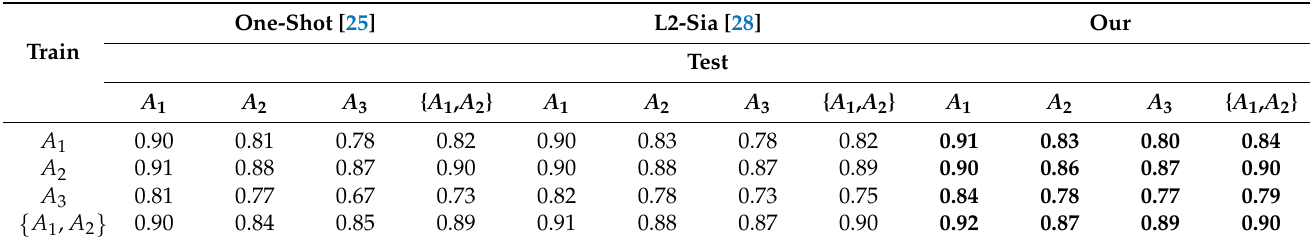
Table 7. Comparison of results achieved by different methods on the dataset splits according to head pose.